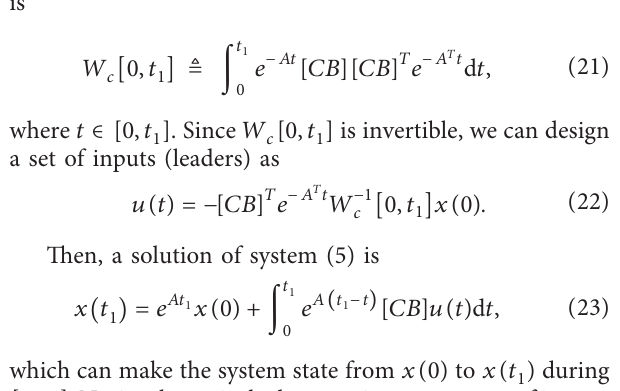
Figure 4: Topology with 9